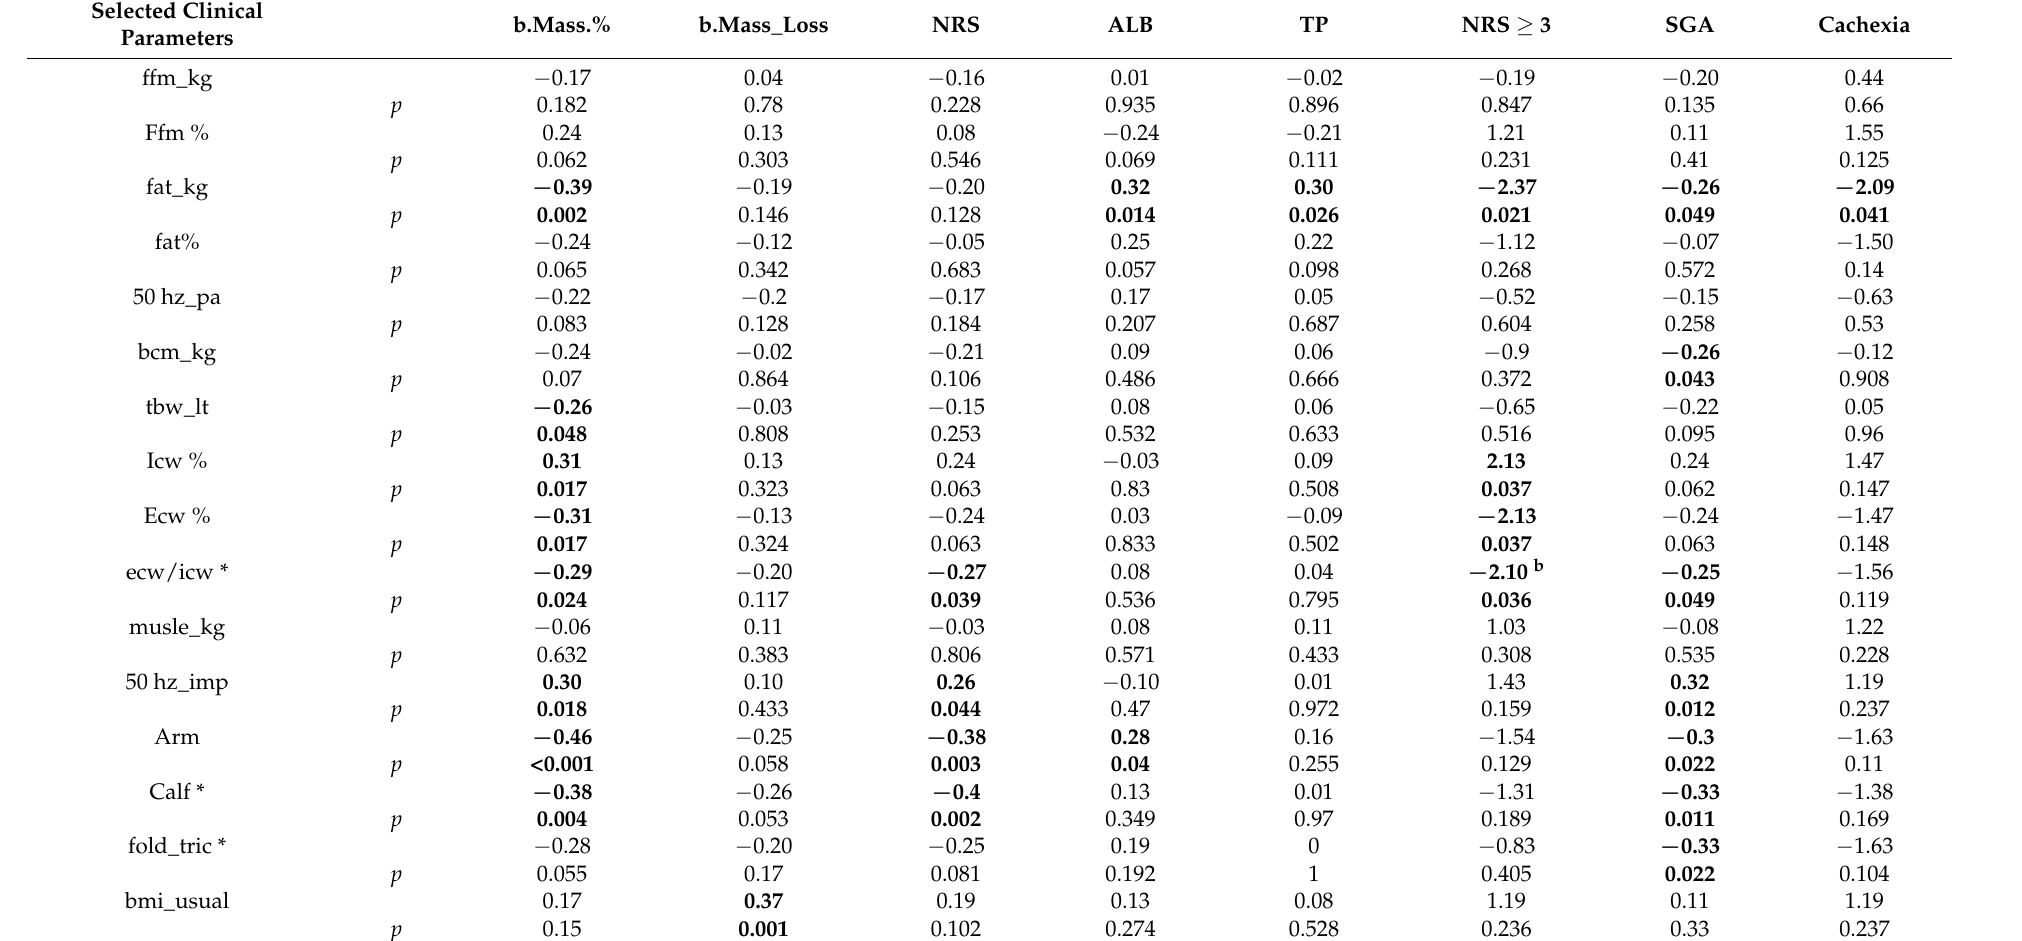
Table 3. Correlations and differences in age, status performance, tumor stage, and other clinical parameters depending on nutritional status, weight loss, albumin, total protein and